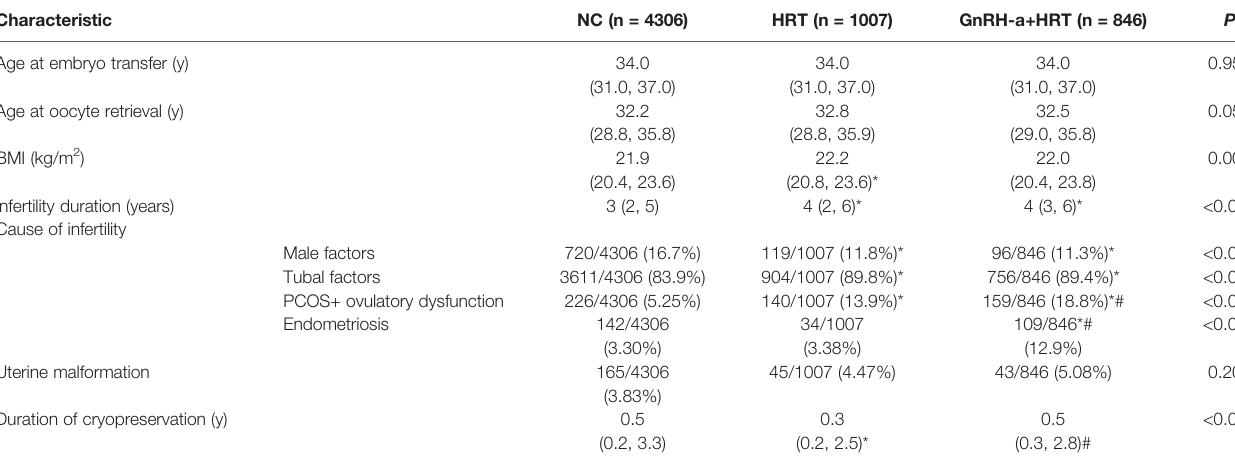
TABLE 1 | Baseline characteristics of participants in the three